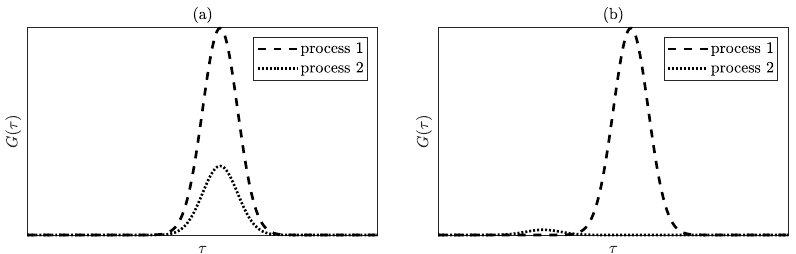
Figure 1. The two scenarios where the corresponding processes/parameters are unidentifiable with ( a ) overlapping peaks and ( b ) one peak of a negligible polarization resistance.